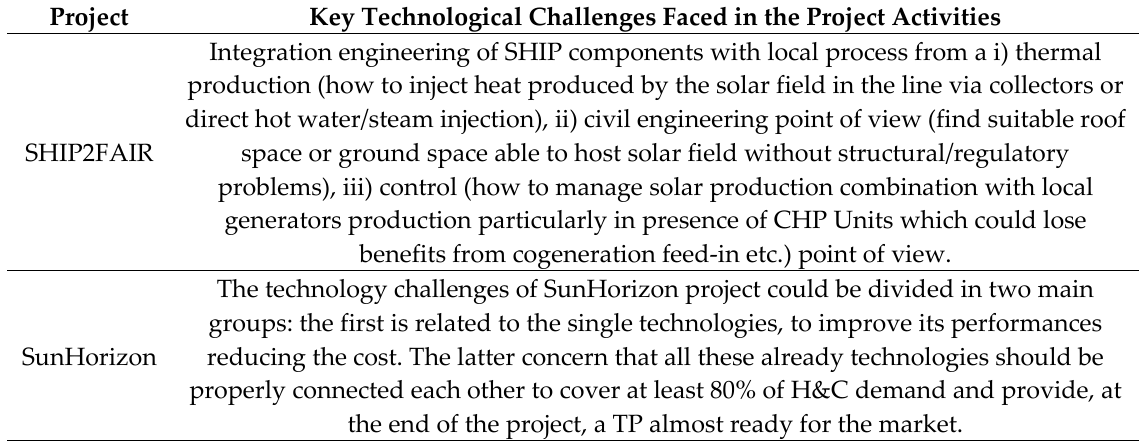
Table 1. Technological